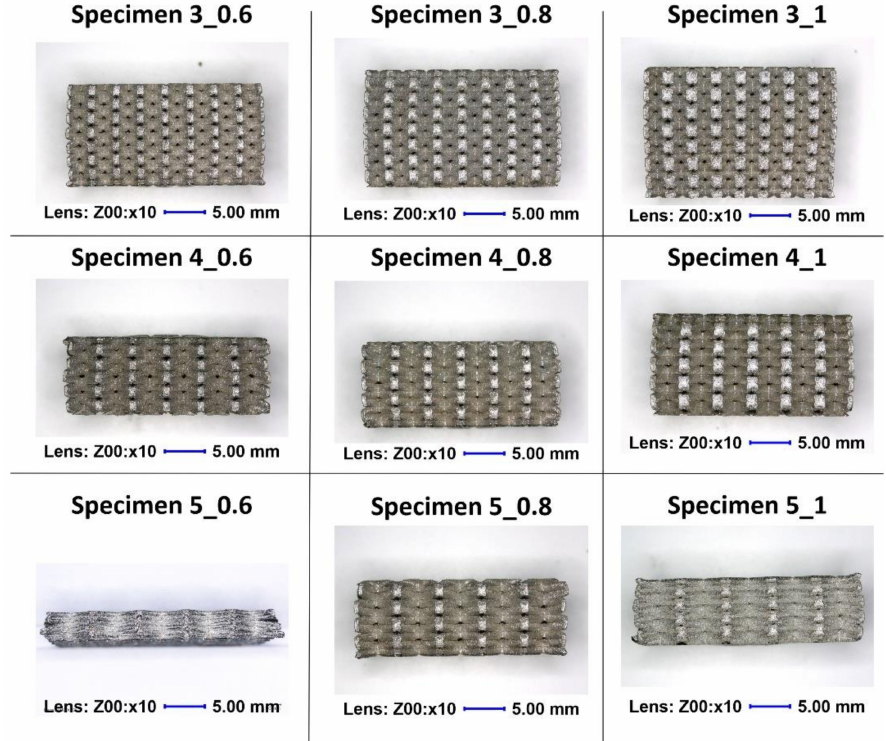
Figure 23. Lattice structure views after impact